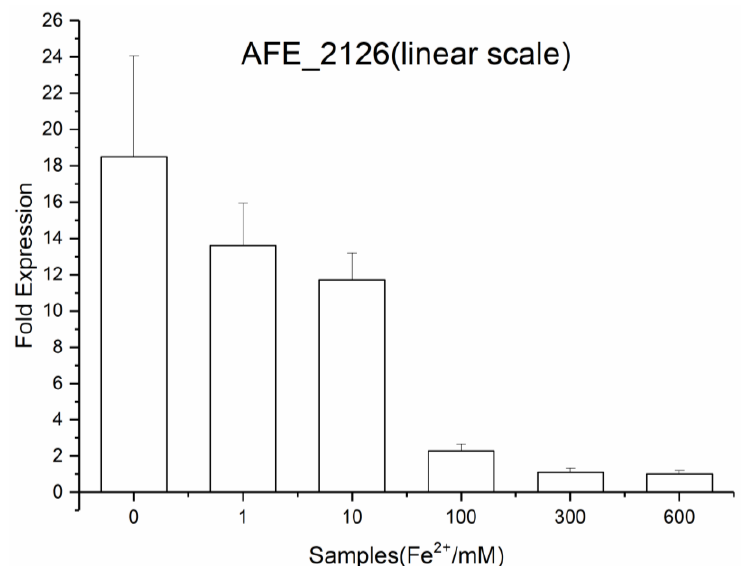
Figure 3. RT-qPCR analysis of the expression profile of AFE_2126 in response to different concentrations of ferrous ion (Fe 2+ ). Data are shown as relative expressions compared to the pooled cDNA sample (the highest concentration of ferrous ion) used as the reference for the microarray experiment. The relative expressions of different ferrous ion concentrations: 600 mM, 300 mM, 100 mM, 10 mM, 1 mM, and 0 mM were 1, 1.1, 2.3, 11.7, 13.6, and 18.5.